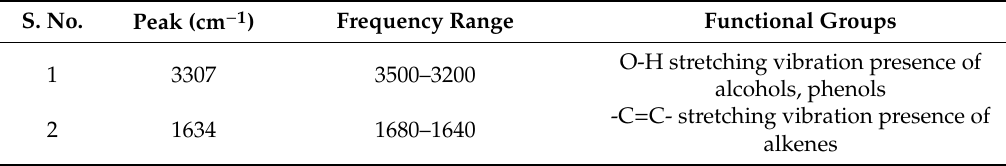
Table 4. FTIR spectra of M. esculenta leaves aqueous